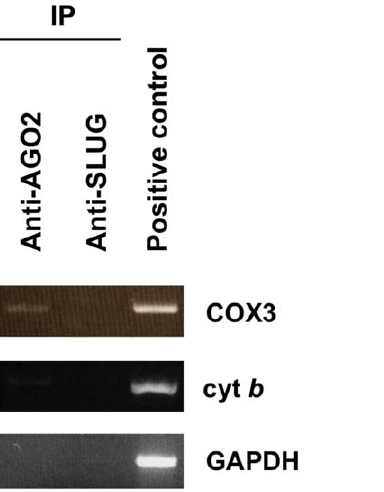
Figure 3. Co-immunoprecipitation of AGO2 and mitochondrial transcripts. Either AGO2, or SLUG, which serves as a negative control were co-immunoprecipitated with associated mRNAs in HeLa protein extracts. Coimmunoprecipitated RNA was extracted with Trizol and subjected to RT-PCR amplification with the indicated primers: cytochrome c oxidase III ( COX3 ), cytochrome b ( cyt b ) and glyceralde- hyde-3-phosphate dehydrogenase ( GAPDH ). Results are indicative of three independent